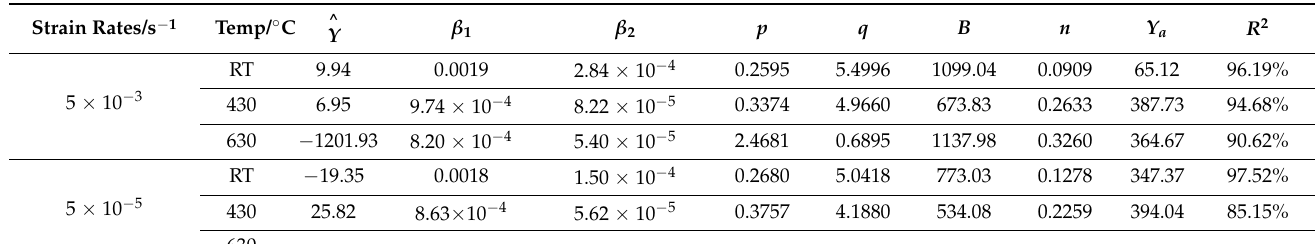
Table 7. Fitted values of the VA model under different temperatures at the strain rates of 5 × 10 − 3 s − 1 and 5 × 10 − 5 s − 1 .